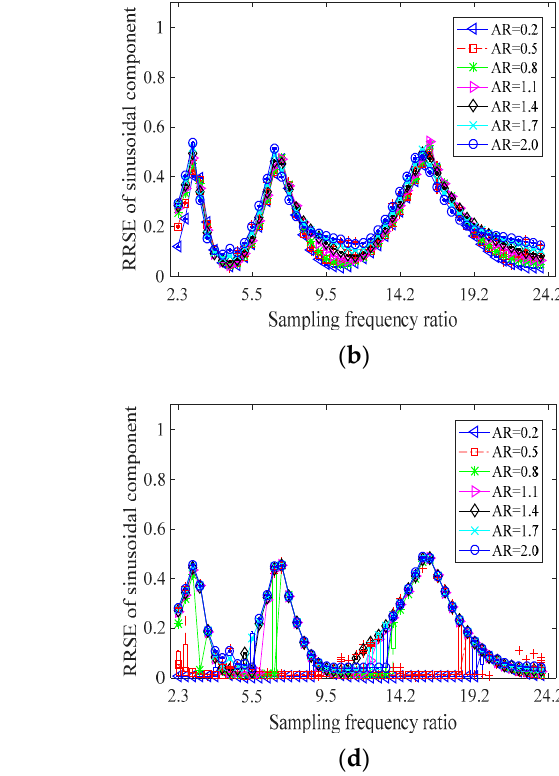
Figure 5. RRSE of the sinusoidal component for the four noise-assisted EMD algorithms: ( a ) EEMD; ( b ) CEEMD; ( c ) CEEMDAN; ( d ) ICEEMDAN.